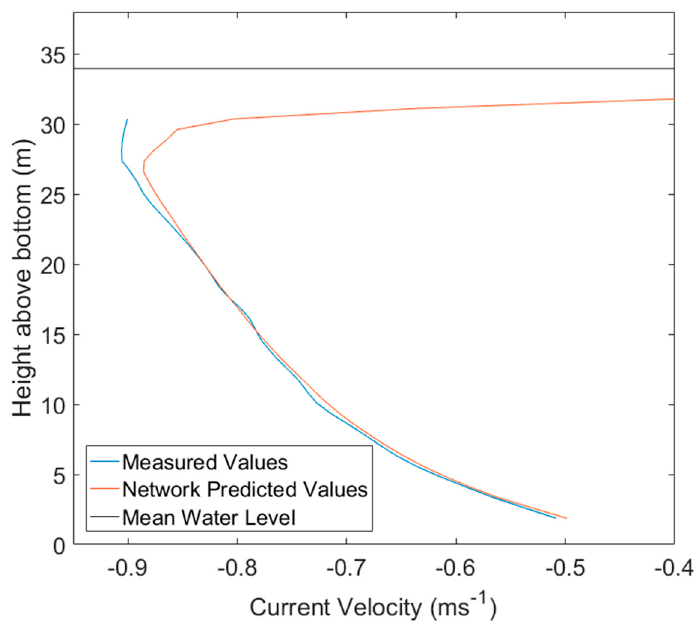
Figure 10. Velocity profile at ADCP-W averaged over 16 spring ebb tides using the BR network. Blue: measured values, and orange: network prediction.